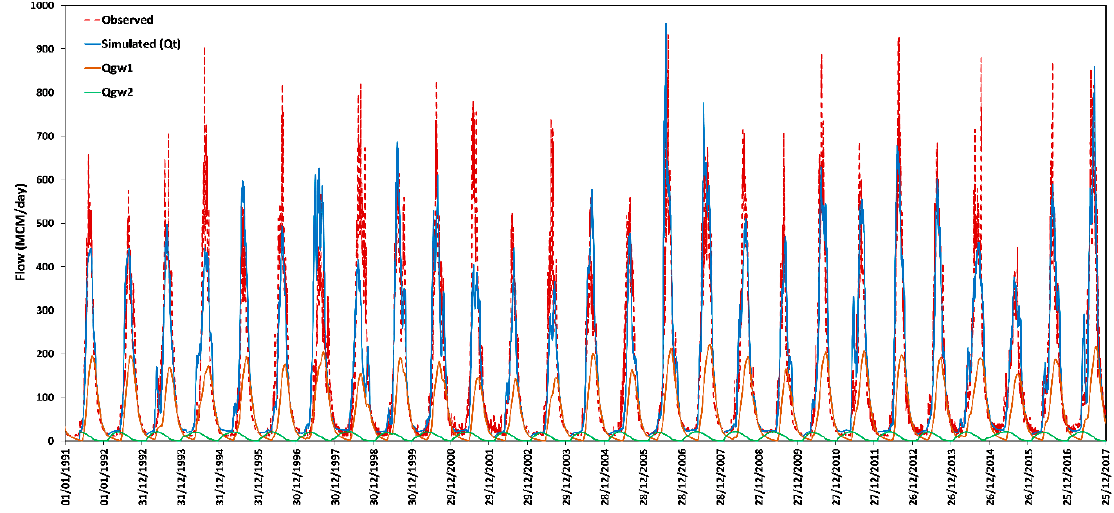
Figure 13. The different hydrograph components at the basin outlet during the period of study.